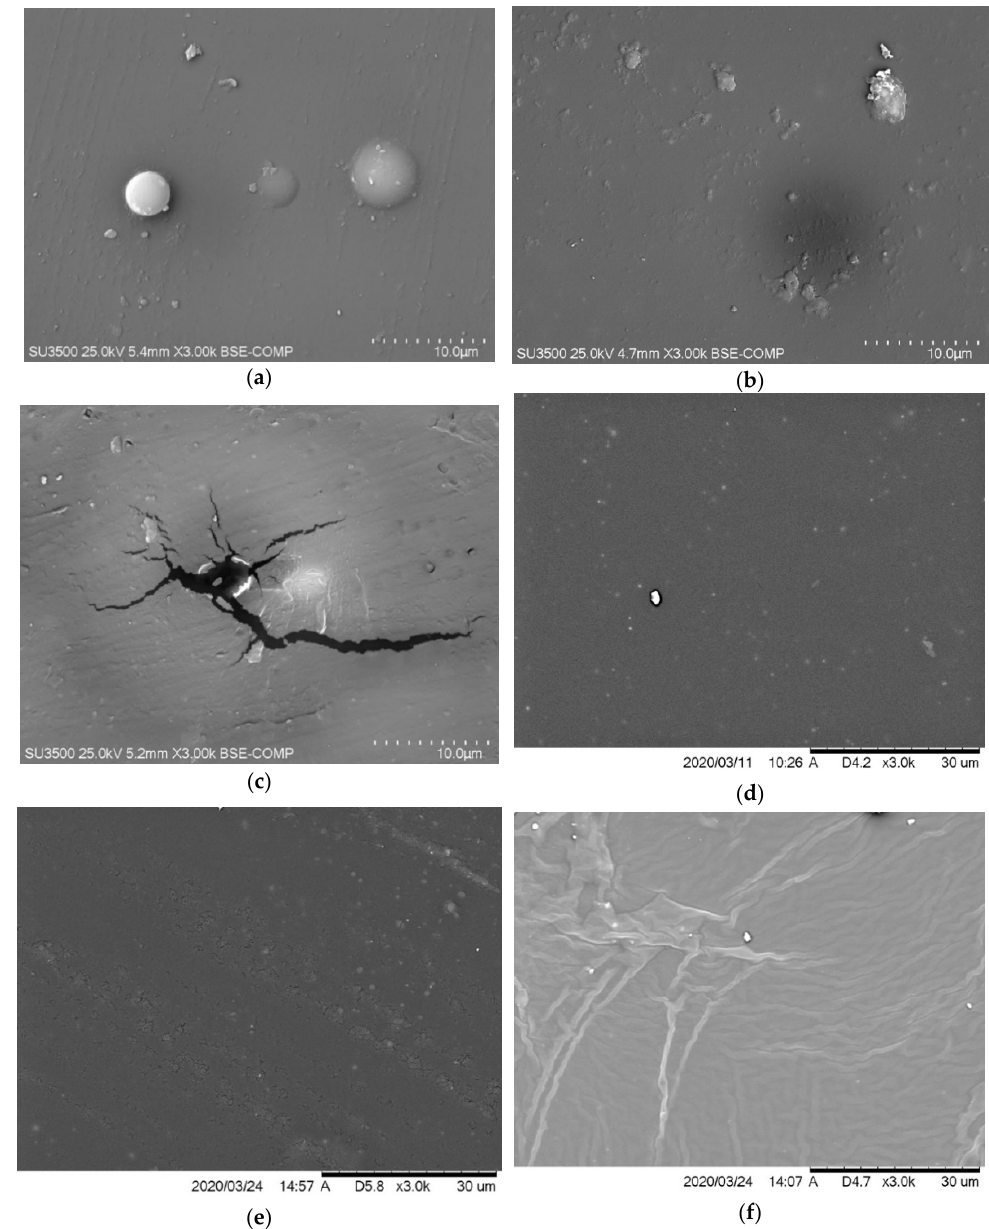
Figure 8. SEM image of the coating containing ( a ) 2% of no. 1 additive, ( b ) 6% of no. 1 additive, ( c ) 2% of no. 2 additive, ( d ) 6% of no. 2 additive, ( e ) 2% of no. 3 additive, and ( f ) 6% of no. 3 additive.